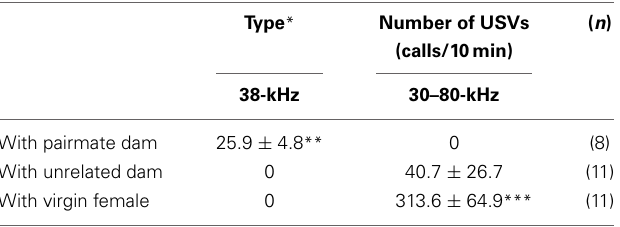
Table 3 | Number of USVs recorded from cages of sires co-housed with different types of females for